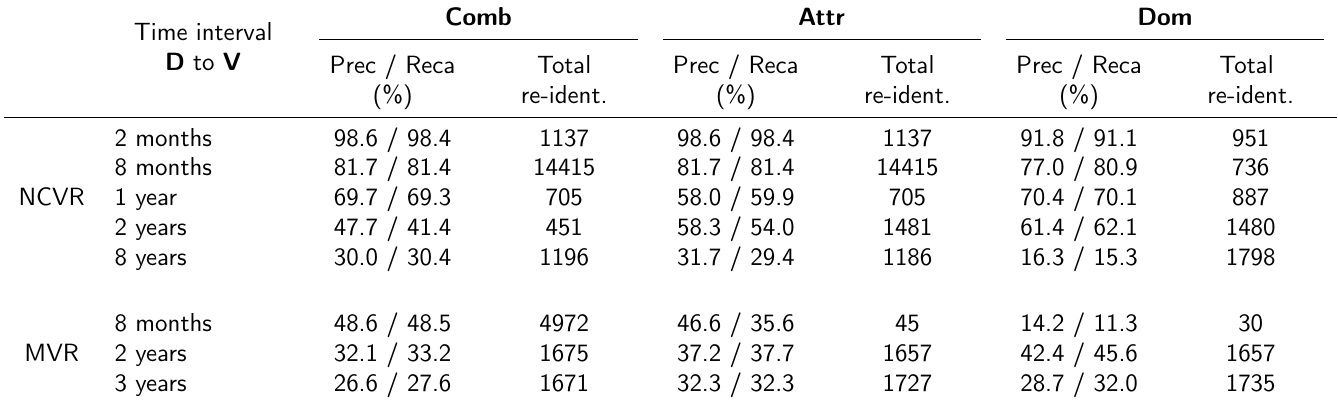
Table 6: Precision (Prec) and recall (Reca) results for plain-text re-identifications for most frequent match-key values. The total number of re-identifications (Total re-ident.) identified by each experiment is also presented. Results are shown for both the NCVR and MVR databases and for different time durations in D and V . Results are further categorised into attack scenarios Comb , Attr , and Dom